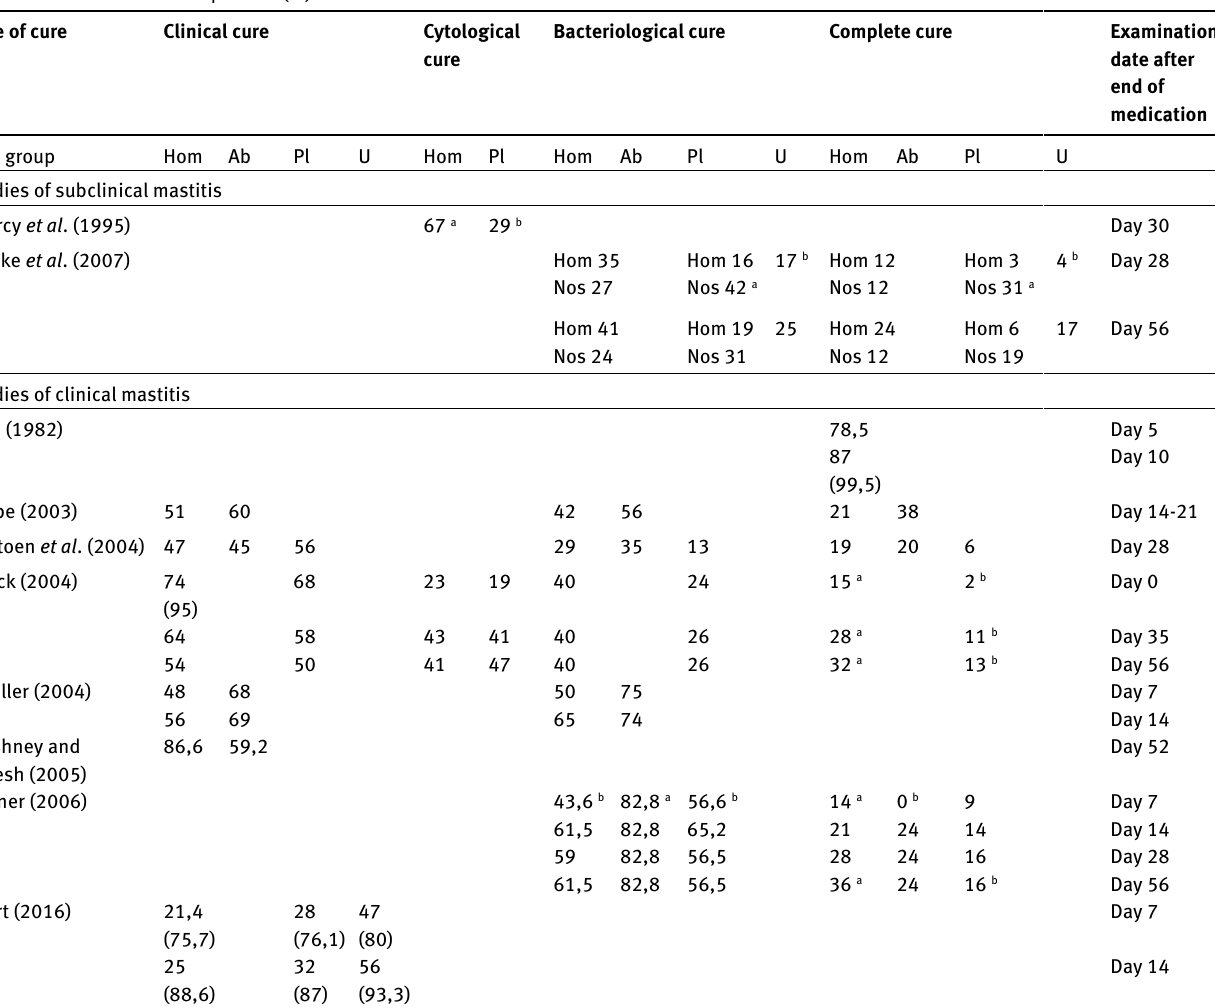
Table 4: Cure rates of udder quarters (%) Type of